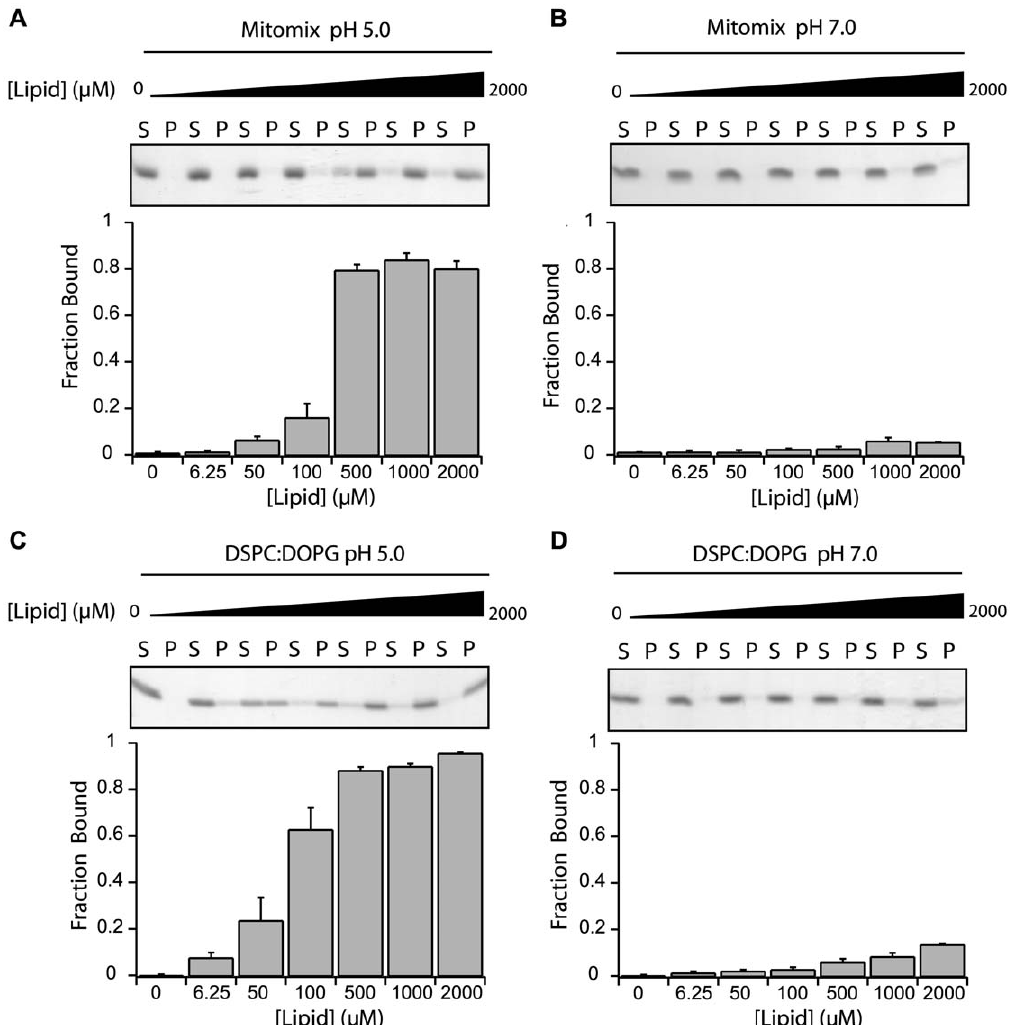
Figure 1. Fis1 lacking its transmembrane domain binds to membranes in a pH-dependent manner. A vesicle sedimentation assay was used to measure the fraction of Fis1 D TM bound as a function of increasing lipid concentration for Mitomix lipids at pH 5.0(A) or pH 7.0(B) or Br 4 DSPC:DOPG lipids at pH 5.0(C) or pH 7.0(D). Each panel shows SDS-PAGE analysis showing supernatant(S) and pellet(P) for increasing vesicle concentrations (above) and quantified by densitometry (below). Fis1 D TM (5 m M) was incubated for 4 hours at 25 u C with indicated concentrations of 100 nm large unilamellar vesicles. Average fraction bound and standard error of the mean were calculated from n=3 independent measurements, except n=5 in (D).